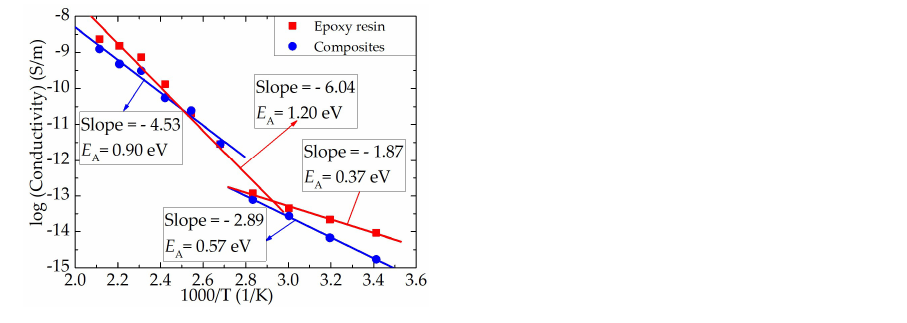
Figure 8. Arrhenius fitting of the conductivity calculated from the conduction current. E A : activation energy. Solid lines are the fitted curves.